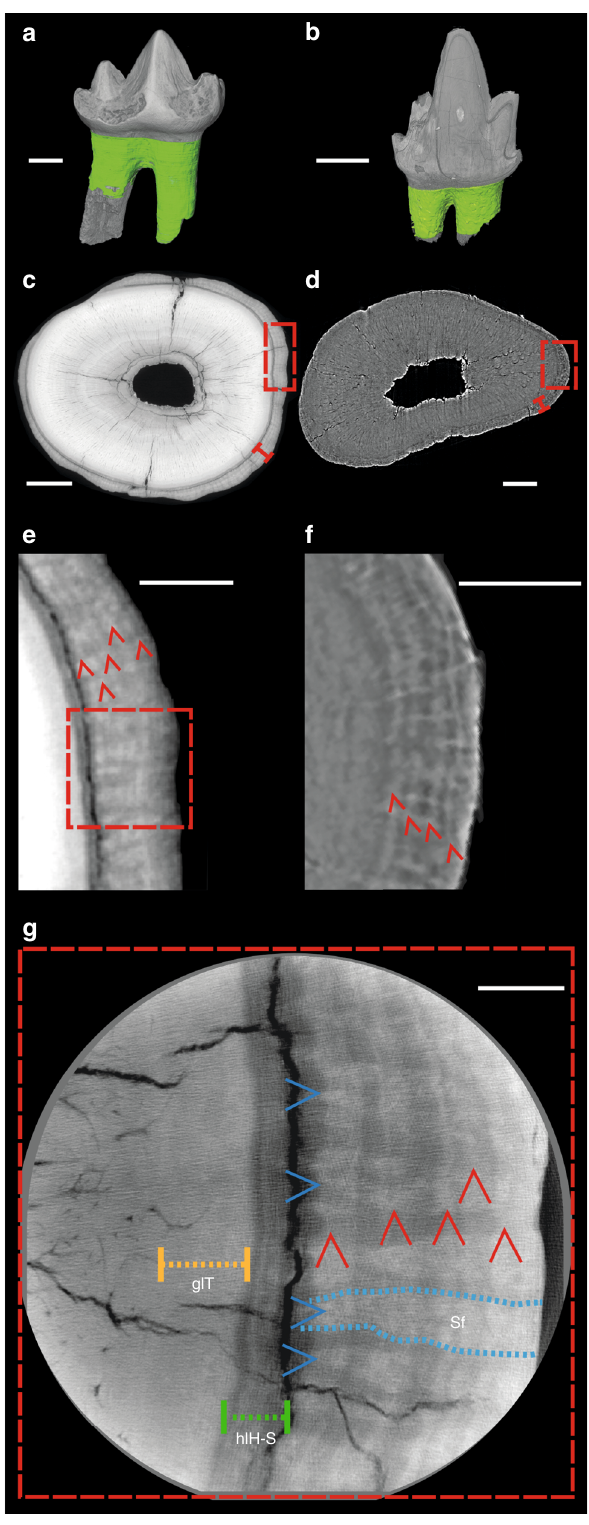
the cementum allowed us to con fi dently distinguish principal annual increments from any accessory increments created by lensing and coalescence (see “ Methods ” ).